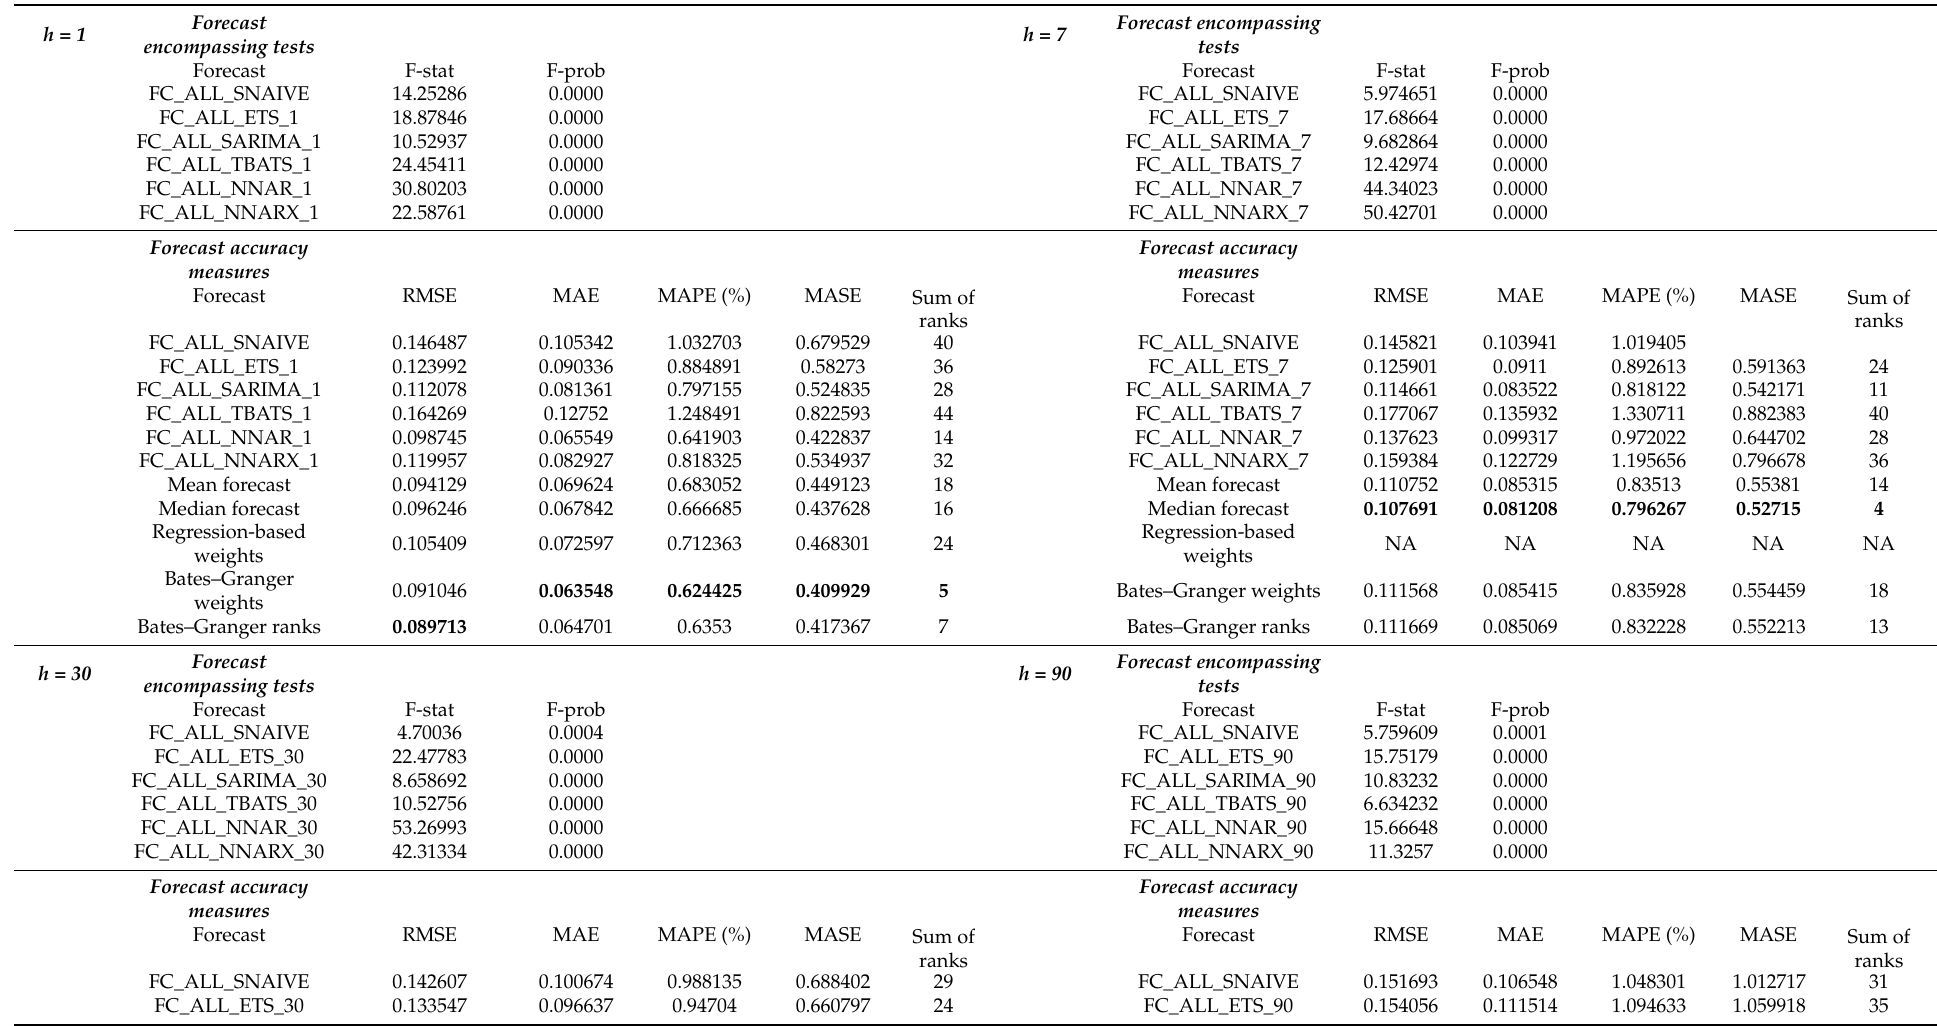
Table 1. Forecast evaluation results for the hotel class ‘all’. Source: STR SHARE Center, own calculations using R and